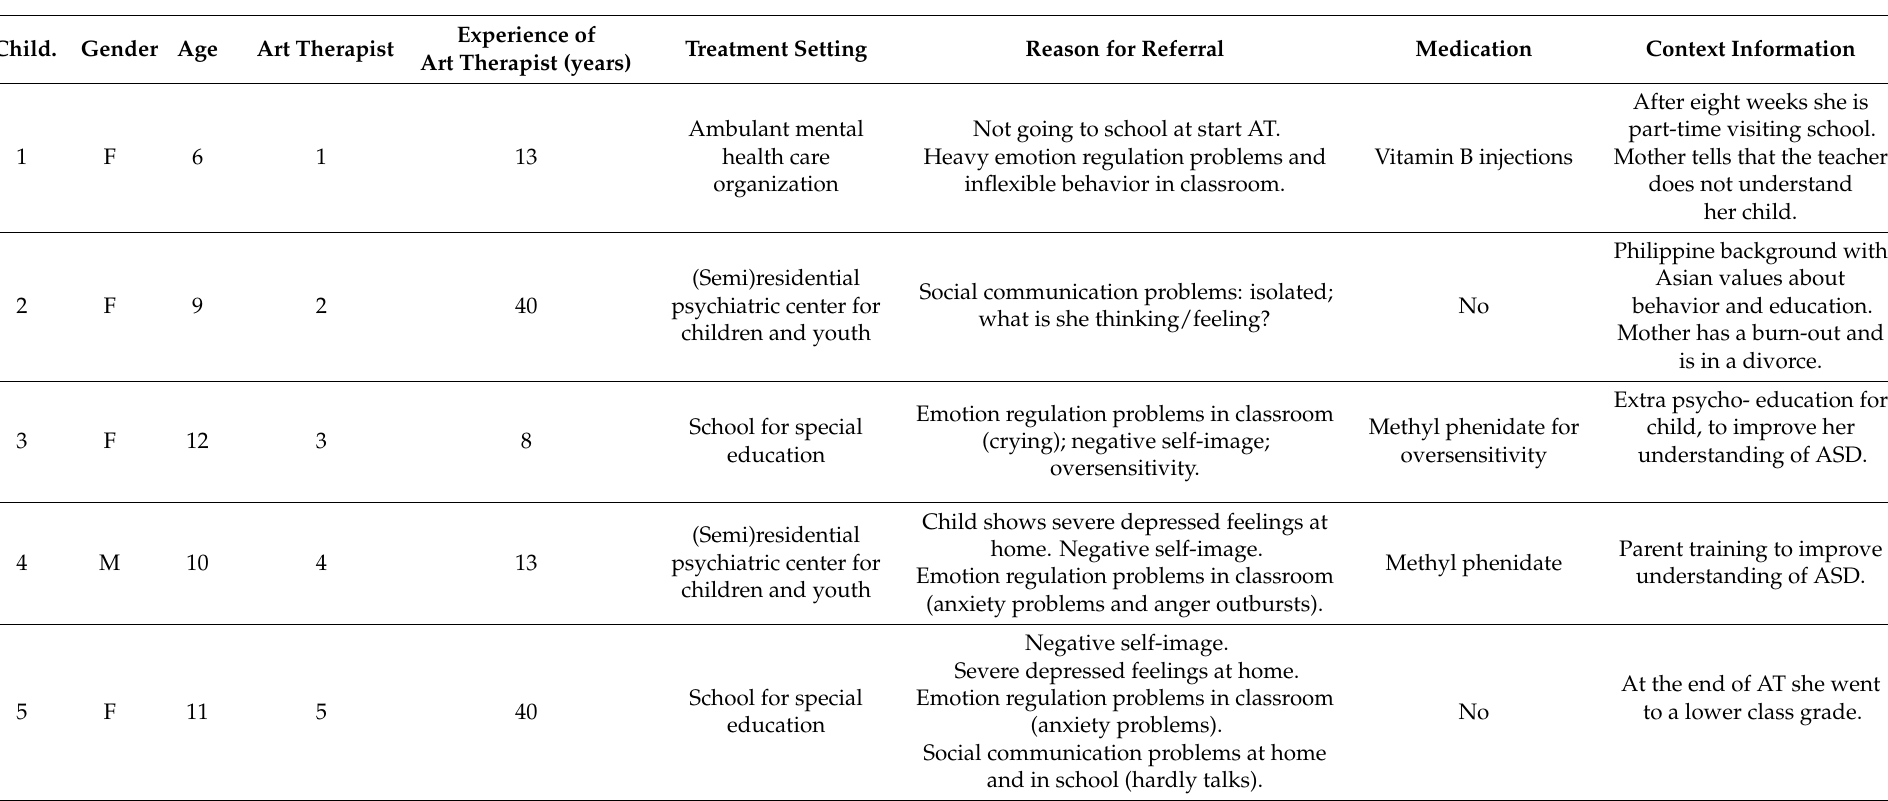
Table A1. Overview of participating children, art therapists, treatment settings, reasons for referral, use of medication, and context information [19] Reprinted/adapted with permission from Elsevier Rights and Permissions, http://s100.copyright.com/mycount/viewrightslinkorders; accessed on 6 July